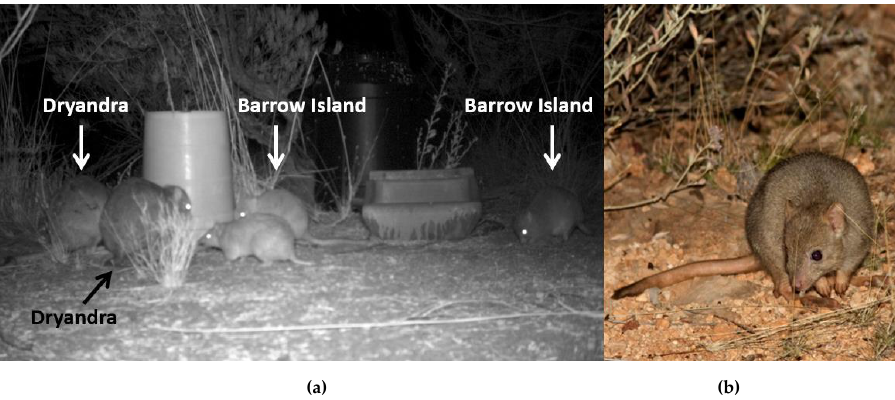
Figure 1. Body size differences between ( a ) Bettongia lesueur from Dryandra (originally Dorre Island) and Barrow Island from a camera trap taken at the Matuwa translocation site, and ( b ) B. lesueur in colour.